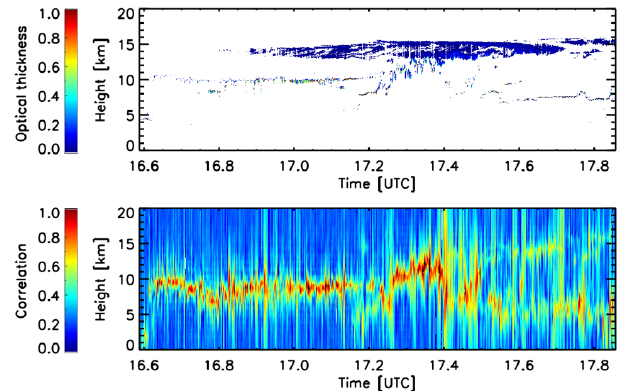
Figure 2. CPL optical thickness (top) and corresponding RSP correlation map (bottom) for 16 September 2013 from 16.6 to